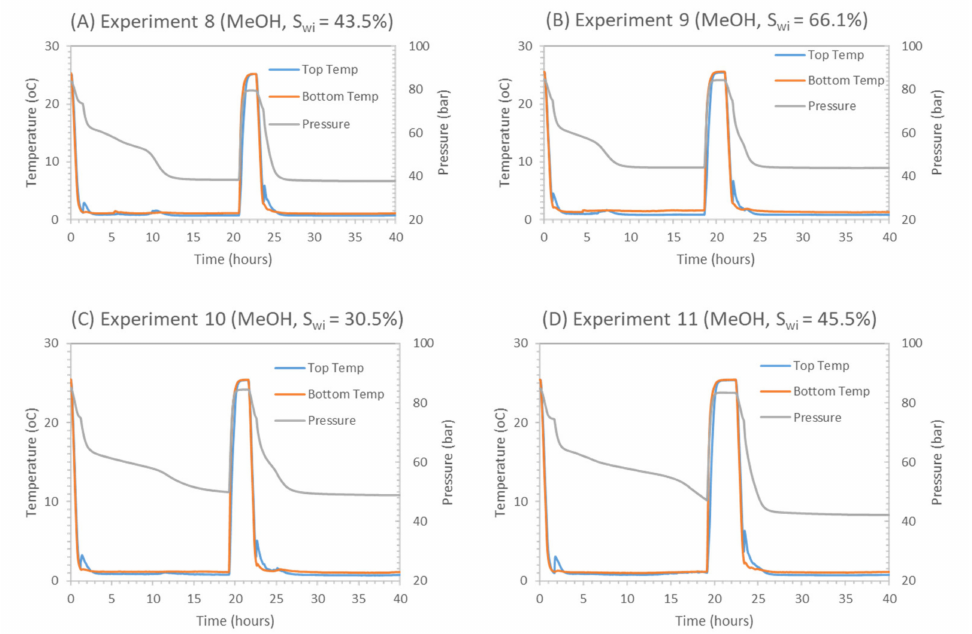
Figure 7. Pressure and temperature (P-T) profiles for CH 4 hydrate formation with 5 wt% MeOH in di ff erent initial solution saturations. ( A ) P-T Profile during methane hydrate formation in the presence of MeOH and S wi = 43.5%; ( B ) P-T Profile during methane hydrate formation in the presence of MeOH and S wi = 66.1%; ( C ) P-T Profile during methane hydrate formation in the presence of MeOH and S wi = 30.5%; ( D ) P-T Profile during methane hydrate formation in the presence of MeOH and S wi = 45.5%.